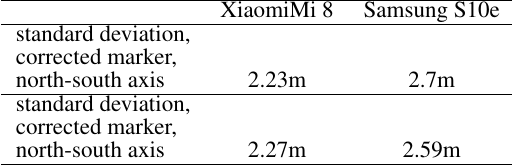
Table 1. Standard deviation of all measurements